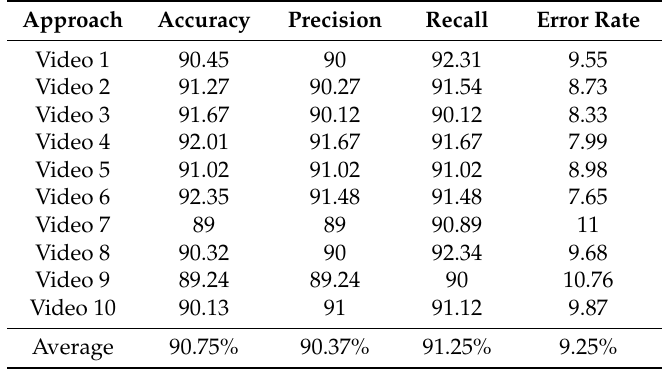
Table 9. Performance evaluation using k-nearest neighbor.